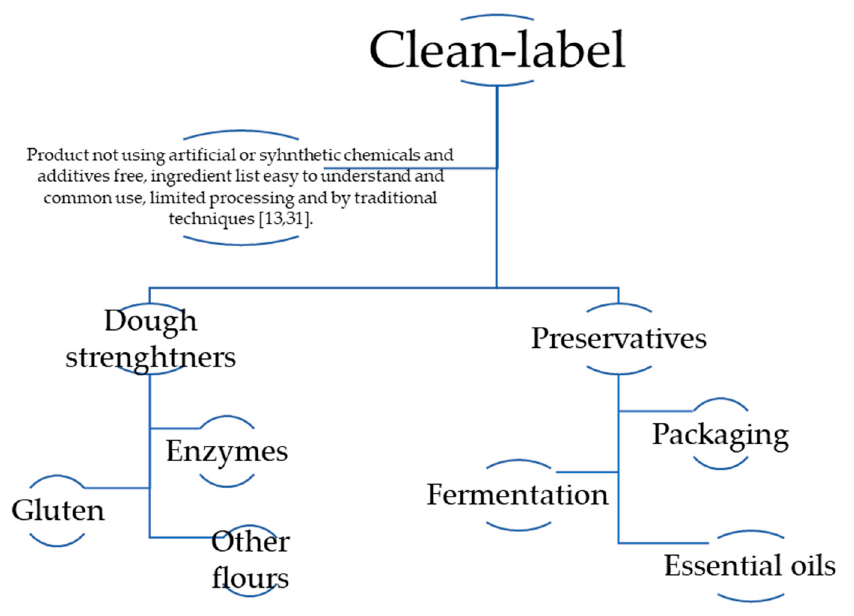
Figure 1. An example of the clean-label definition and possible solutions in clean-label bread formulations [12,13,31].